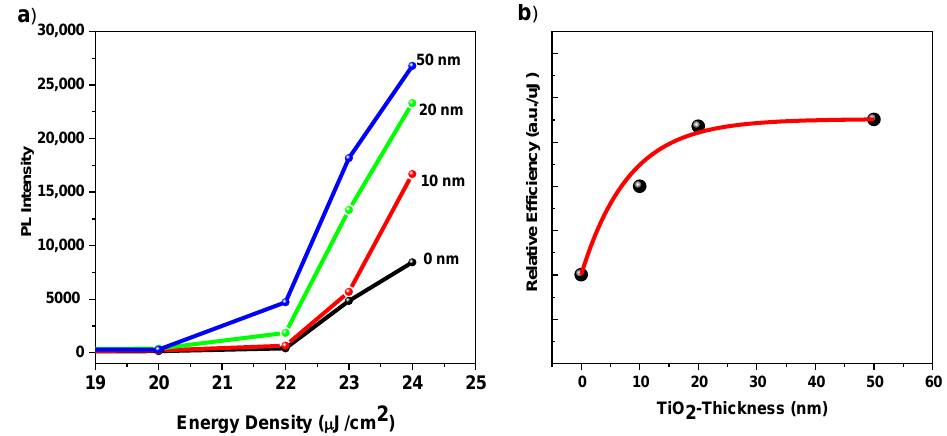
Figure 6. ( a ) The integrated PL intensity vs. pulse energy density and ( b ) the slopes (Differential Quantum Efficiency) of the fitted lines beyond the threshold in intensity-pump energy depending curves as a function of the c-TiO 2 film thickness. In ( b ), the black dots are for the experimental data and the red line is by